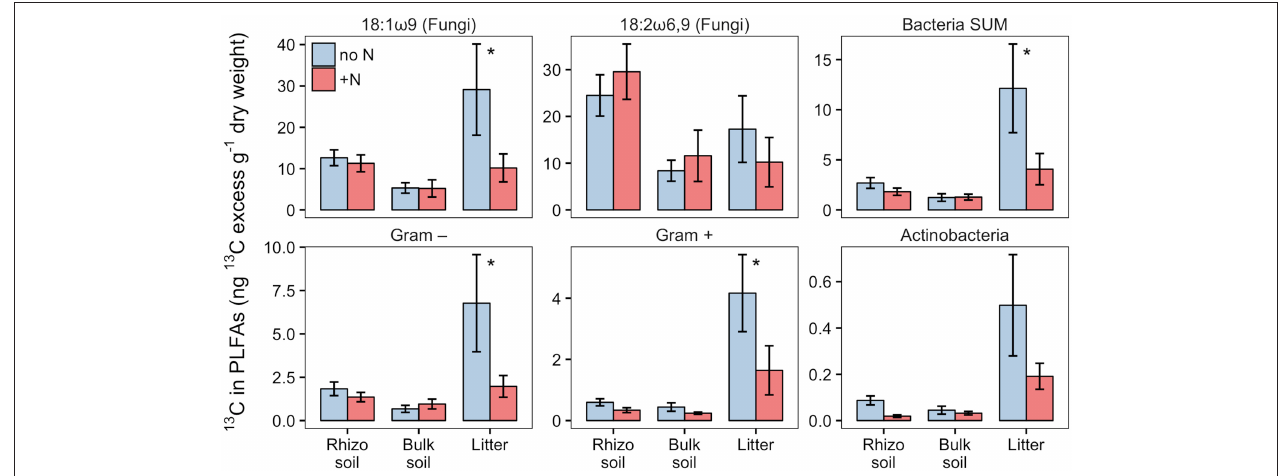
FIGURE 10 | 13 C-excess in PLFAs per g dry weight in N-treated and untreated compartments of dual-labeled ( 13 C and 15 N) plant boxes. Enrichment of bacteria-specific PLFAs in the litter compartment indicates allocation of photoassimilated 13 C via ECM hyphae to root-distant bacteria. Significant differences between untreated (no N) and N-treated side ( + N) are indicated with asterisks (Mann-Whitney U -test for paired samples; p > 0.05; n = 6). Error bars represent the standard